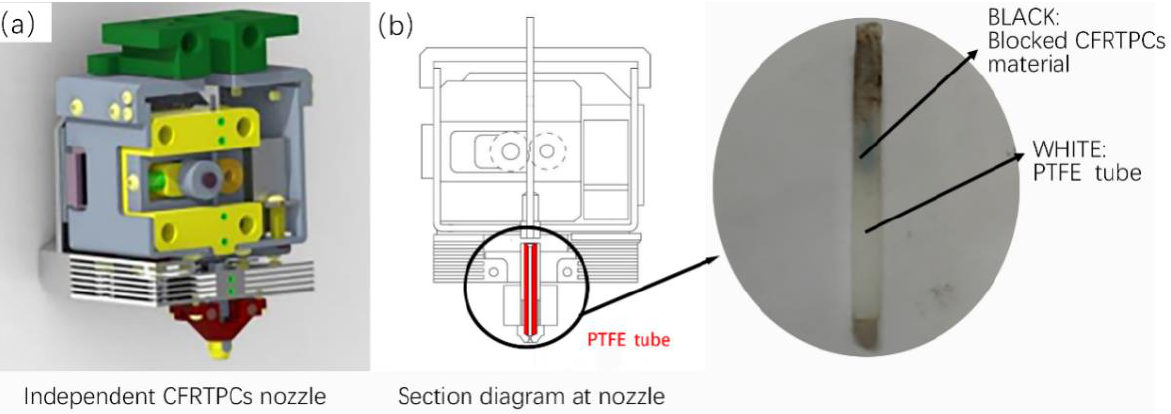
Figure 3. CFRTPC nozzle structure and blockage, ( a ) 3D image of a CFRTPC independent printing nozzle, ( b ) schematic diagram of the position of PTFE tube in nozzle.